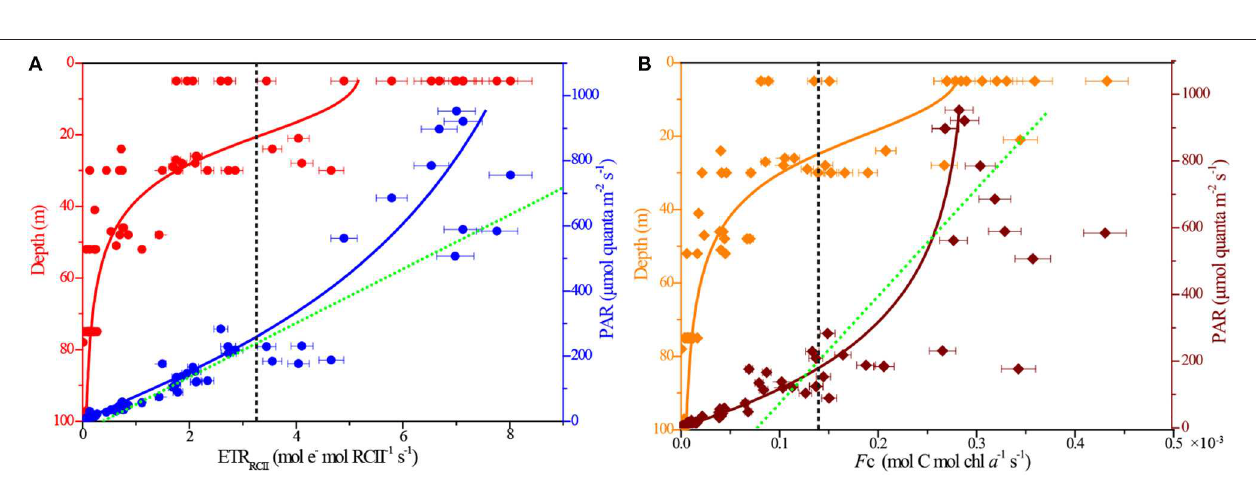
FIGURE 5 | Depth and light responses of rates of ETR RCII and F C . (A) ETR RCII vs. depth ( R 2 = 0.68) and PAR ( R 2 = 0.87); (B) F C vs. depth ( R 2 = 0.96) and PAR ( R 2 = 0.83). The black dashed lines, respectively, indicate their average values. The green dashed lines, respectively, represent the theoretical exponential model of Webb et al. (1974) for the P vs. E curves.